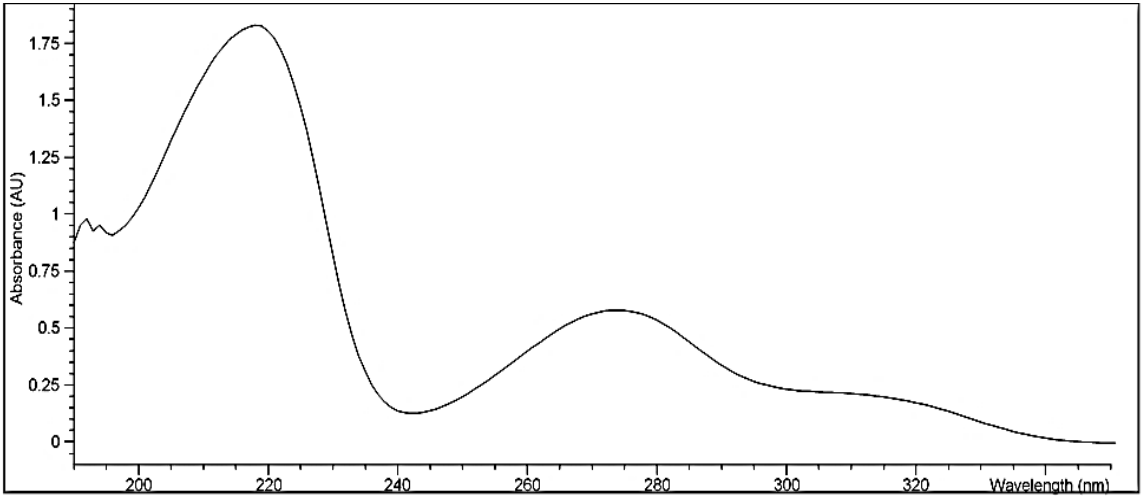
Figure 1. UV – vis spectrum of bergenin isolated from B. ciliata. Figure 1. UV–vis spectrum of bergenin isolated from B. ciliata